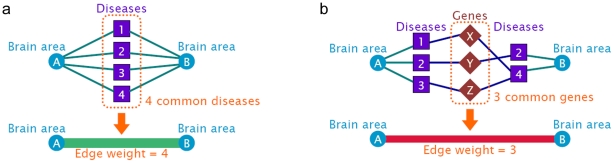
A schematic of forming connections for the common disease and gene networks.A connection is formed according to common diseases (a) and common genes (b) shared between two brain areas. The number of shared diseases or genes is used as the edge weight between two brain areas.